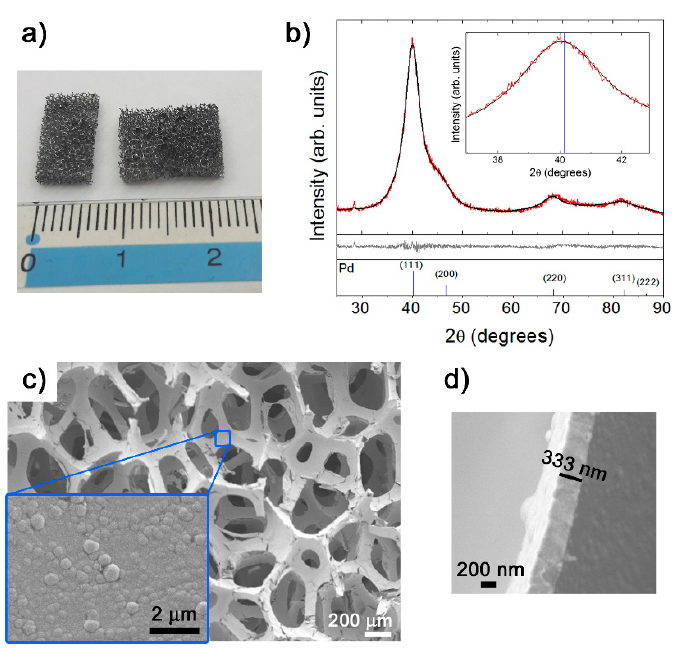
Figure 1. ( a ) Picture of pieces of Pd-coated polyurethane (PU) foam and ( b ) experimental XRD pattern (red line). The calculated fit using the HighScore Plus software is also shown (black line) (the peak at 29 ◦ belongs to the sample holder). The difference between the experimental and calculated profiles and the reference pattern for fcc-Pd depicted in the middle and bottom panels, respectively. SEM images of ( c ) Pd-coated PU foam and on-top morphology of the PdP layer (inset) and ( d ) cross-section depicting the thickness of the layer.